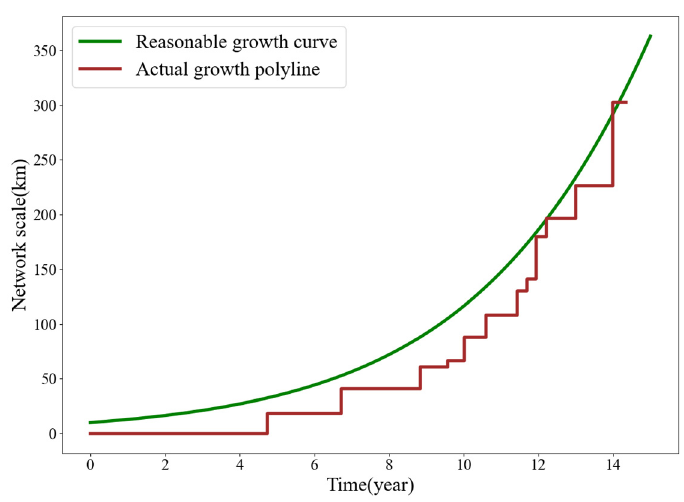
Figure 7. Growth curves of Chengdu rail transit, actual, and projected, based on Equation (16).